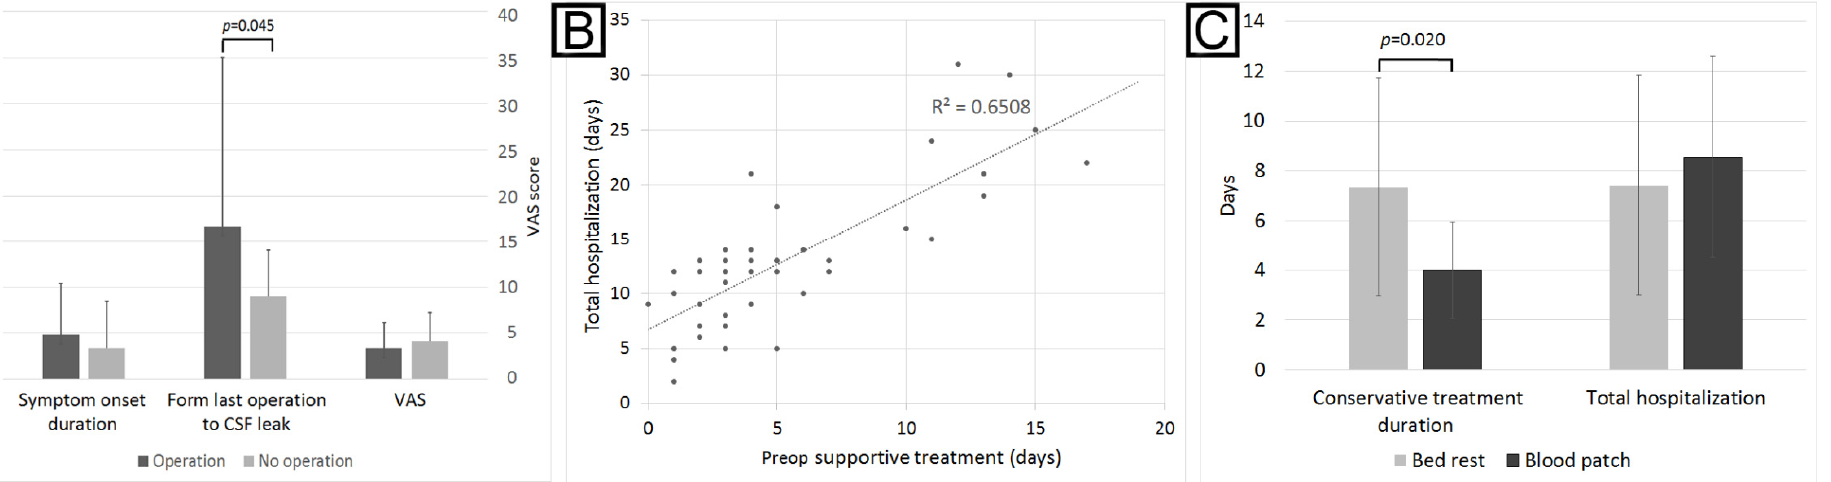
Figure 2. Subgroup analysis of surgery-related and spinal CSF leak. Panel ( A ): in all surgery-related CSF leak, only “interval from the last operation to CSF leak” was related to clinical decision to reoperate. Panel ( B ): in all surgery-related CSF leak, there was a strong correlation between preop supportive durations and total hospitalization duration, which indicated that earlier reoperation can shorten hospital stay. Panel ( C ): In spontaneous spinal and lumbar puncture-related CSF leak, patients had, on average, 4 days of conservative treatments before being referred for blood patch. Patients without blood patch needed an average of 7.33 days of conservative treatments. However, there was no difference in total hospital stay.